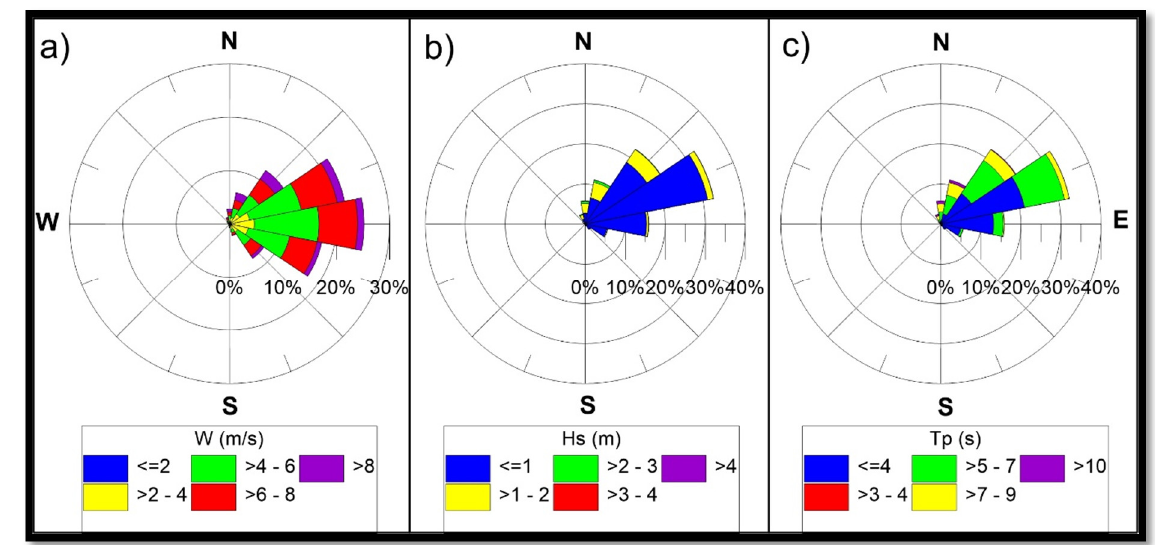
Figure A1. Roses showing the direction and magnitude of ( a ) wind velocity, ( b ) wave height, and ( c ) peak period. Reanalysis data from [83].